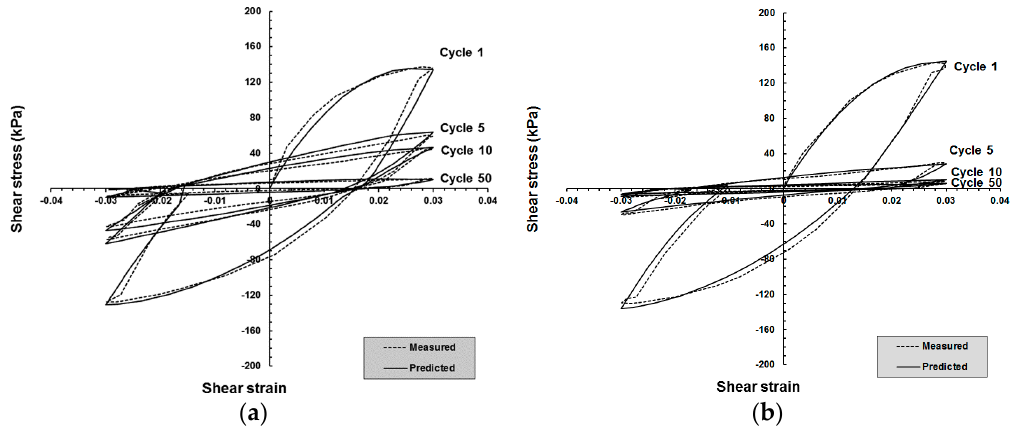
Figure 15. Verification of the predicted results (360 days submersion, 0.45 MPa): ( a ) basic; ( b ) acid.